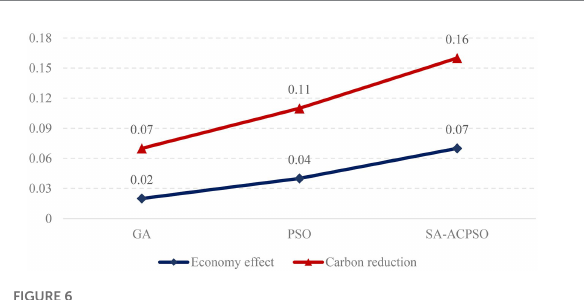
FIGURE 6 The economy effect and carbon reduction using different optimization methods.